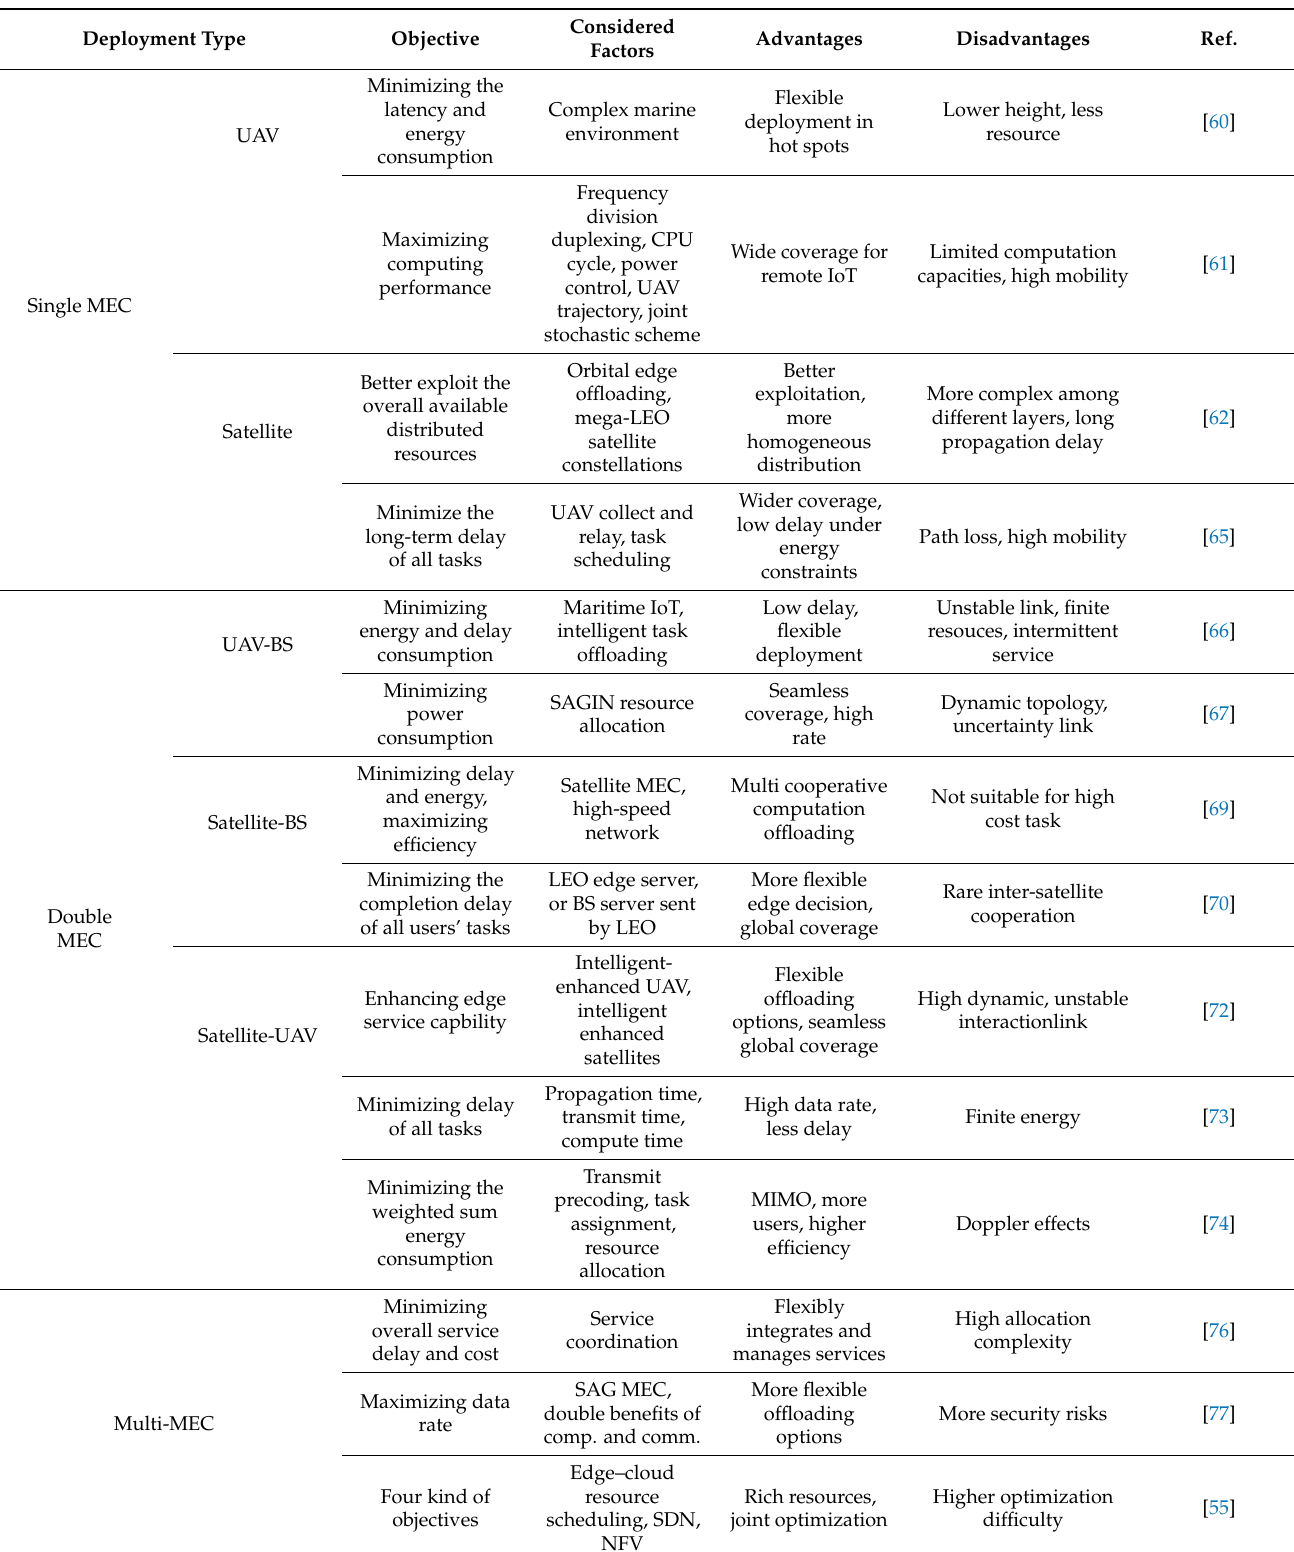
Table 1. Summary of related works on MEC